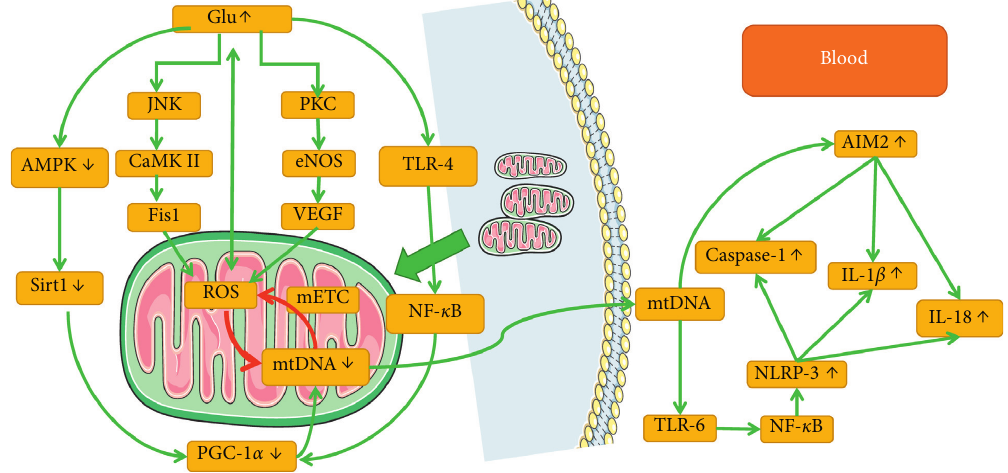
Figure 1: mtDNA, mitochondrial oxygen stress, and inflammation in